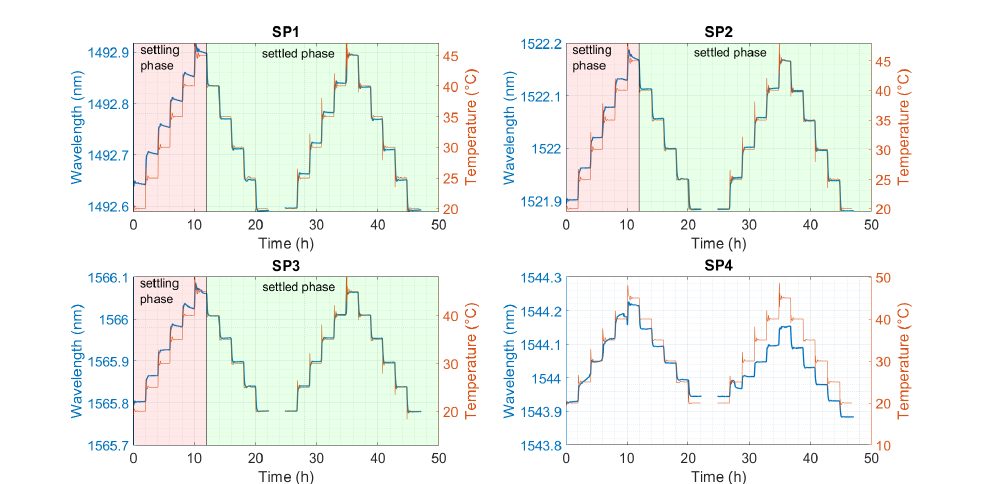
Figure 6. Representative behaviors of the FBGs of each sensor’s encapsulation in the electrolyte. SP1: optical fiber in PEEK capillary, single-point mounting; SP2: optical fiber in fused silica tube with polyimide coating, single-point mounting; SP3: optical fiber in fused silica tube, removed polyimide coating, single-point mounting; SP4: optical fiber in fused silica tube, removed polyimide coating, double-point mounting.